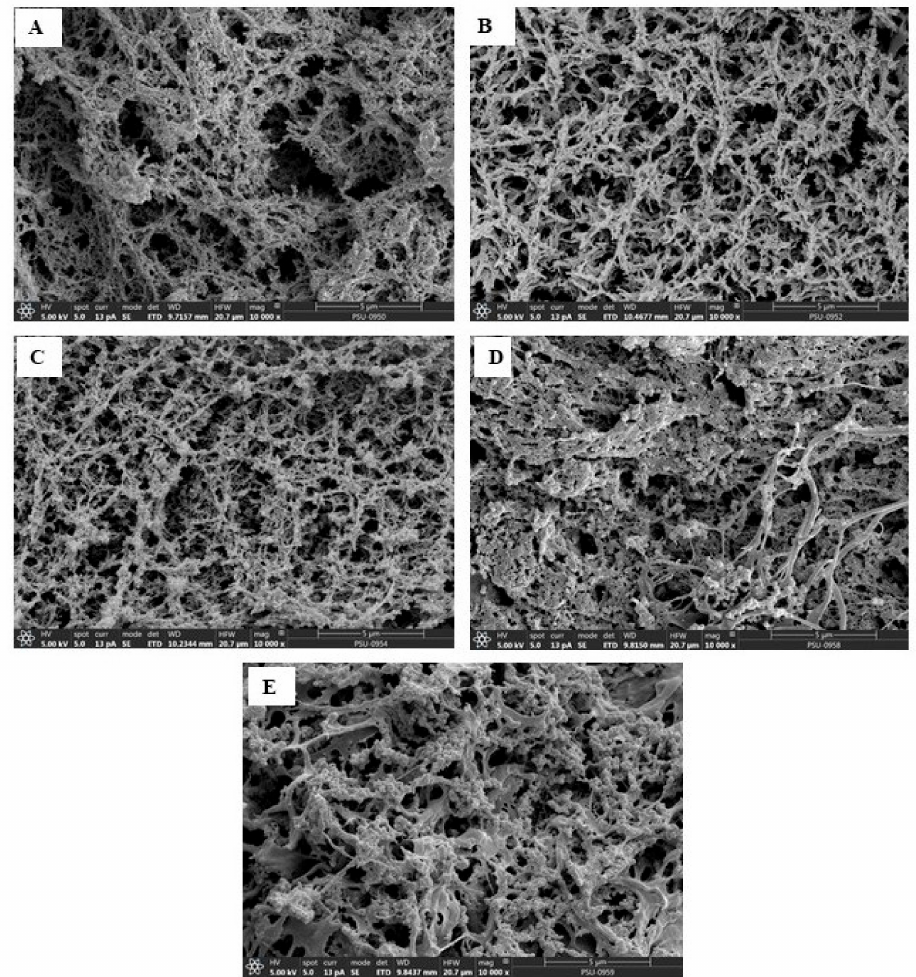
Figure 3. Electron microscopic images of threadfin bream surimi gel without and with psyllium husk at different levels. CON: ( A ), SPH-1 ( B ), SPH-2 ( C ), SPH-3 ( D ), and SPH-4 ( E ). Magnification: 10,000 × . Caption: See Figure